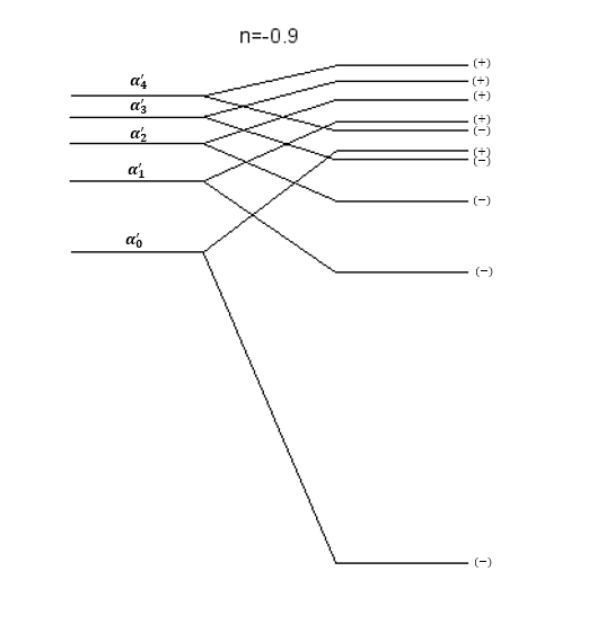
Figure 5: Schematic diagram showing splitting of energy levels with n = − 0.9.